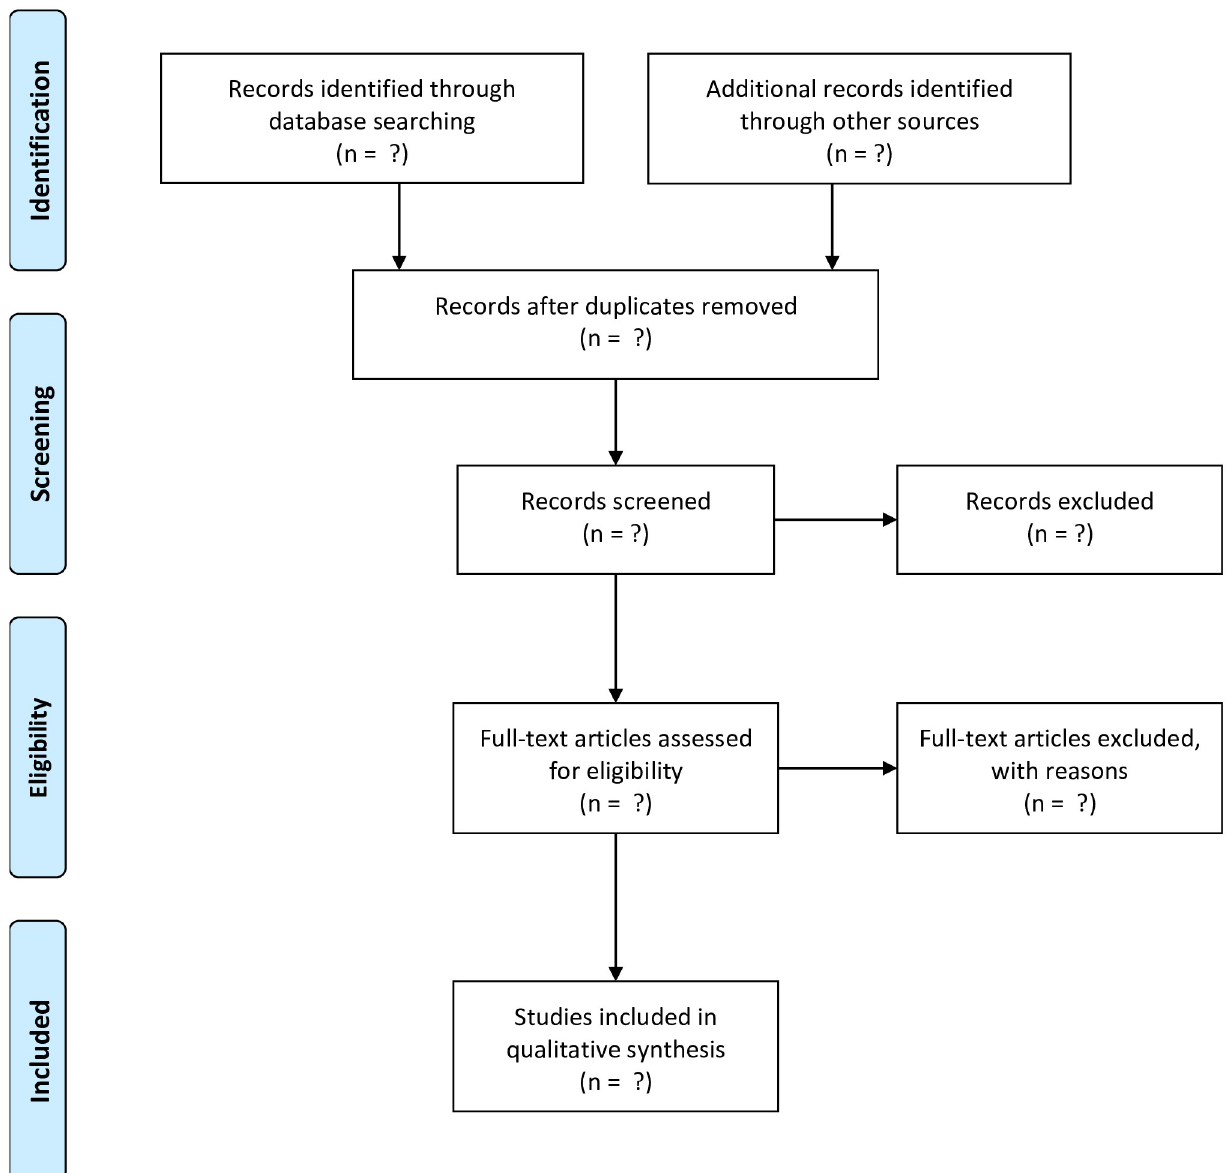
Fig 1. PRISMA-flow chart for study